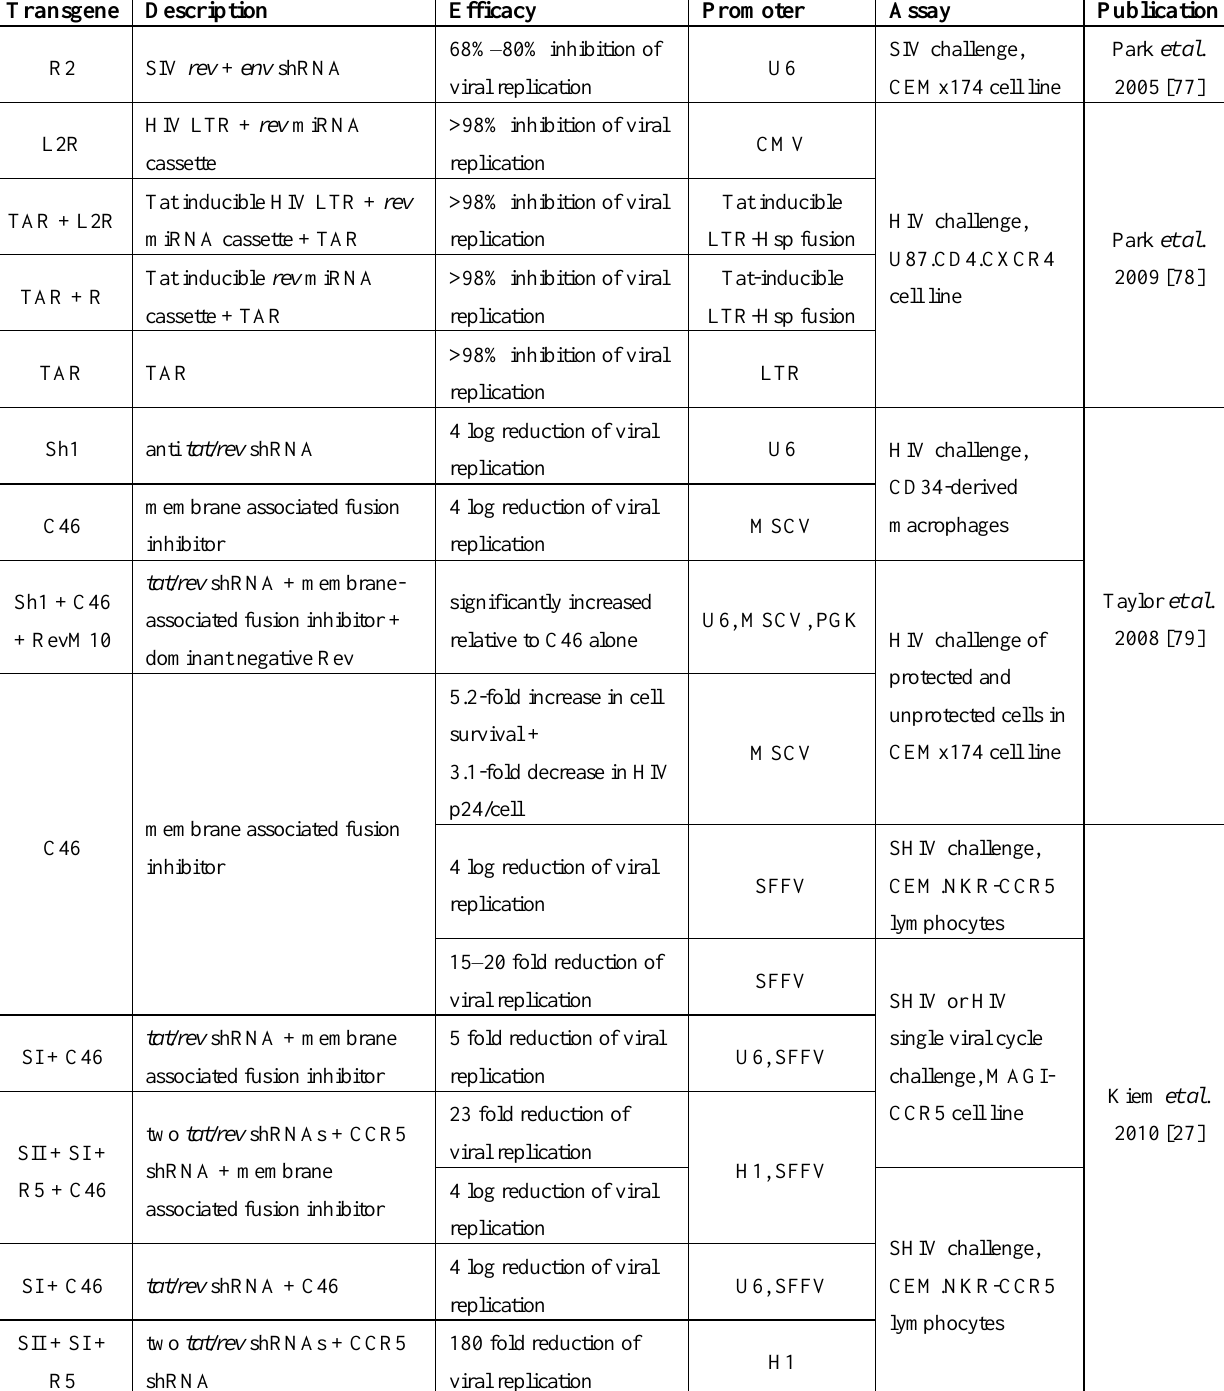
Table 1. Anti-HIV Transgenes in FV Vectors. C46: membrane associated HIV fusion inhibitor; CMV: cytomegalovirus immediate early promoter; LTR: long terminal repeat; H1: human H1 RNA promoter; Hsp: heat shock promoter; L2R: LTR + rev miRNA; MSCV: murine stem cell virus promoter; PGK: phosphoglycerate kinase promoter; R2: SIV rev shRNA; R5: CCR5 shRNA; RevM10: dominant negative Rev; SFFV: spleen focus forming virus promoter; Sh1: anti tat/rev shRNA; SHIV: simian-human immunodeficiency virus; SI: tat/rev shRNA; SII: tat/rev shRNA; SIV: simian immunodeficiency virus; TAR: HIV trans-activation response element; U6: human U6 small nuclear RNA Pol III